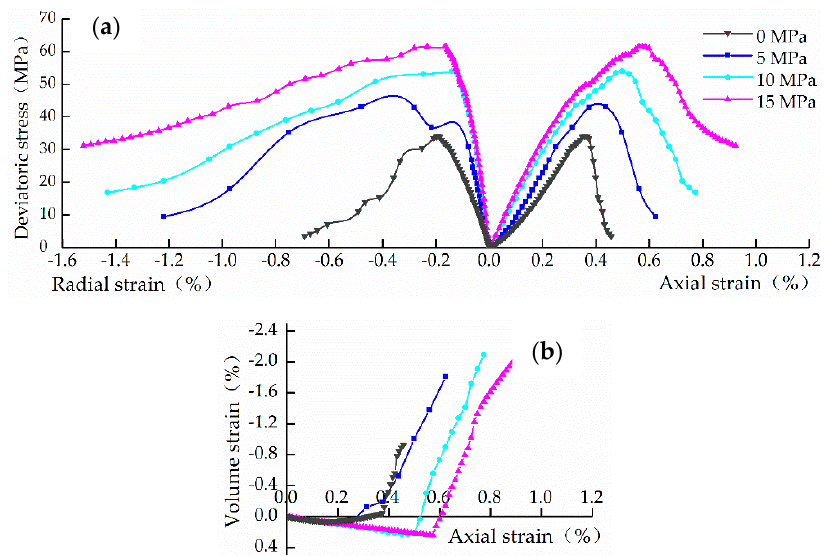
Figure 1. Triaxial compression test curves of ( a ) deviatoric stress vs. axial strain and radial strain and ( b ) volume strain vs. axial strain.